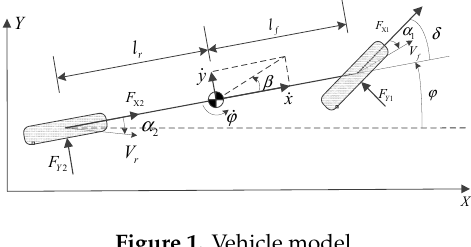
Figure 1. Vehicle model.